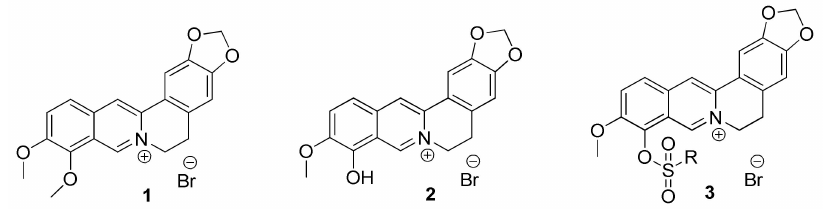
Figure 1. The molecular structures of isoquinoline alkaloid berberine 1 , berberrubine 2 and sulfonate derivatives of 9-demetoxyberberine 3